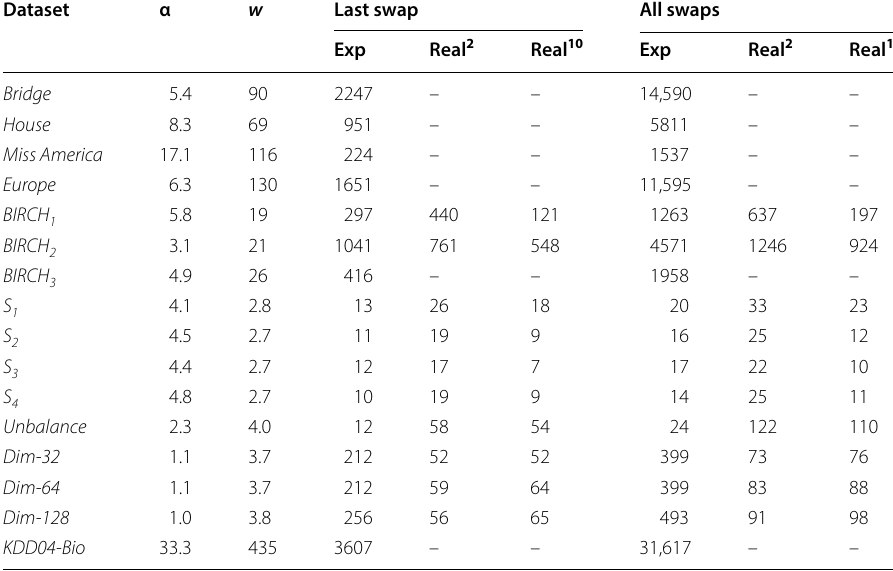
Table 4 Expected number of iterations (Exp) for the last successful swap is estimated as 1/ p ( k / α ) 2 , which is multiplied by log w to obtain the value for all swaps =